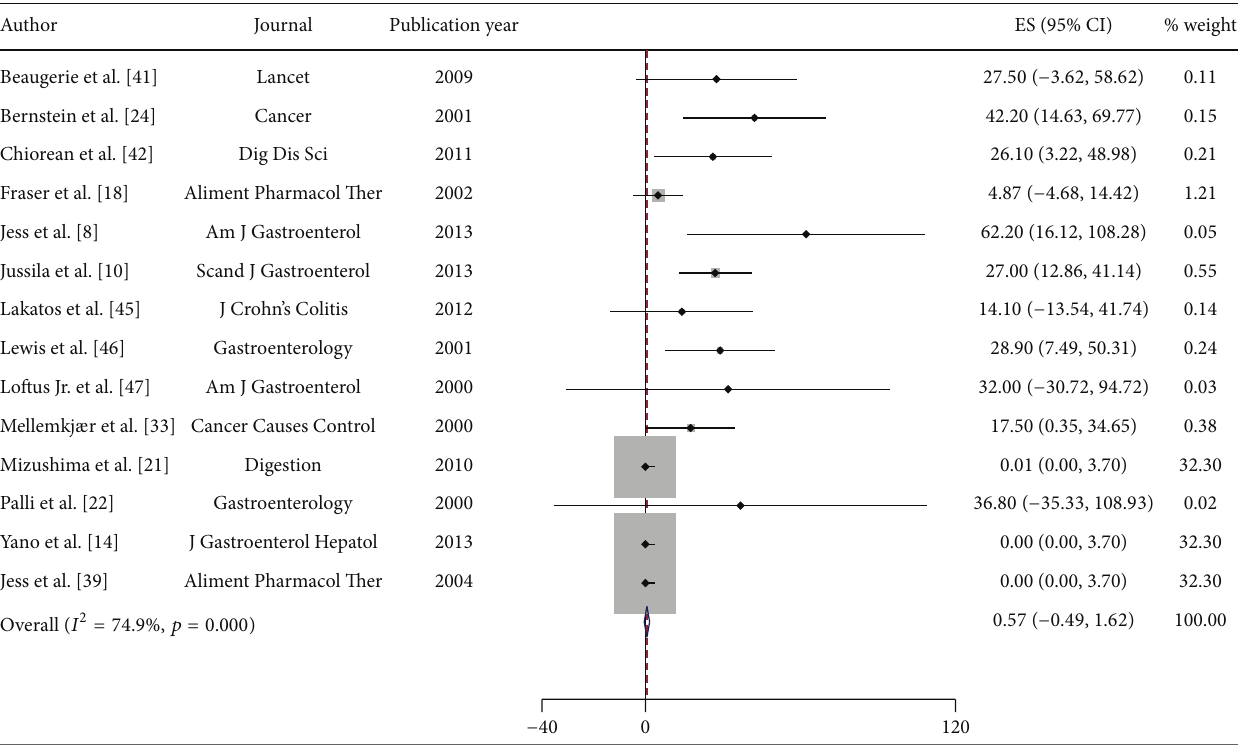
Figure 4: Incidence of lymphoma in patients with Crohn’s Disease (CD). Each incidence estimate is presented followed by the 95% confidence intervals (CIs). Each square in the plot indicates the point estimate of the incidence. The diamond represents the summary incidence from the pooled studies. Error bars depict the 95%